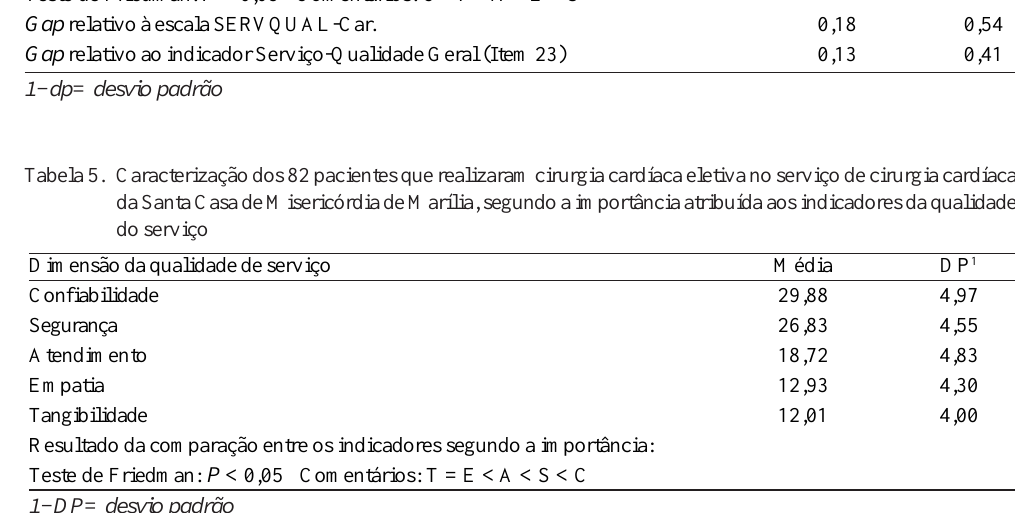
Tabela 4. Caracterização dos 82 pacientes que realizaram cirurgia cardíaca eletiva no serviço de cirurgia cardíaca da Santa Casa de Misericórdia de Marília, segundo os indicadores da qualidade de serviço, obtidos por meio da escala SERVQUAL-Car Indicador da qualidade de serviço / Dimensão Gap relativo ao indicador Segurança Gap relativo ao indicador Atendimento Gap relativo ao indicador Empatia Gap relativo ao indicador Tangibilidade Gap relativo ao indicador Confiabilidade